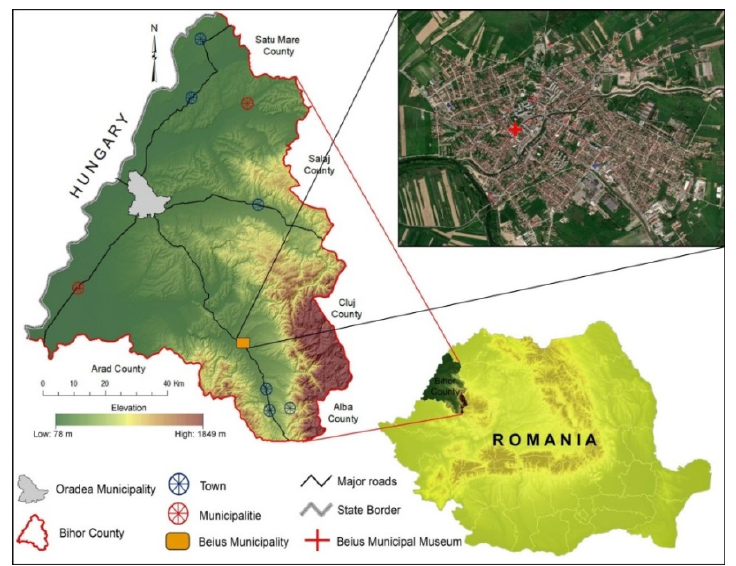
Figure 1. Location of Beiu ș Municipal Museum in Romania and Bihor County .